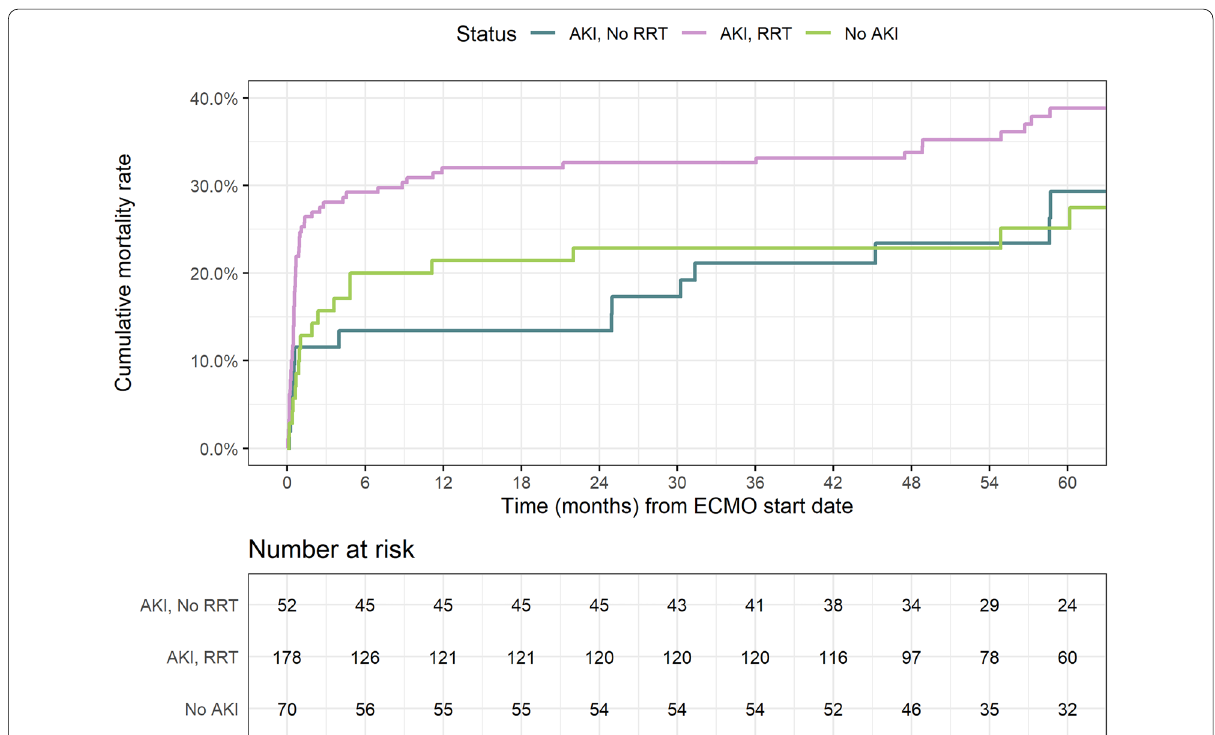
Fig. 1 Kaplan–Meier estimates of long-term mortality according to acute kidney injury (AKI) and renal replacement therapy (RRT)